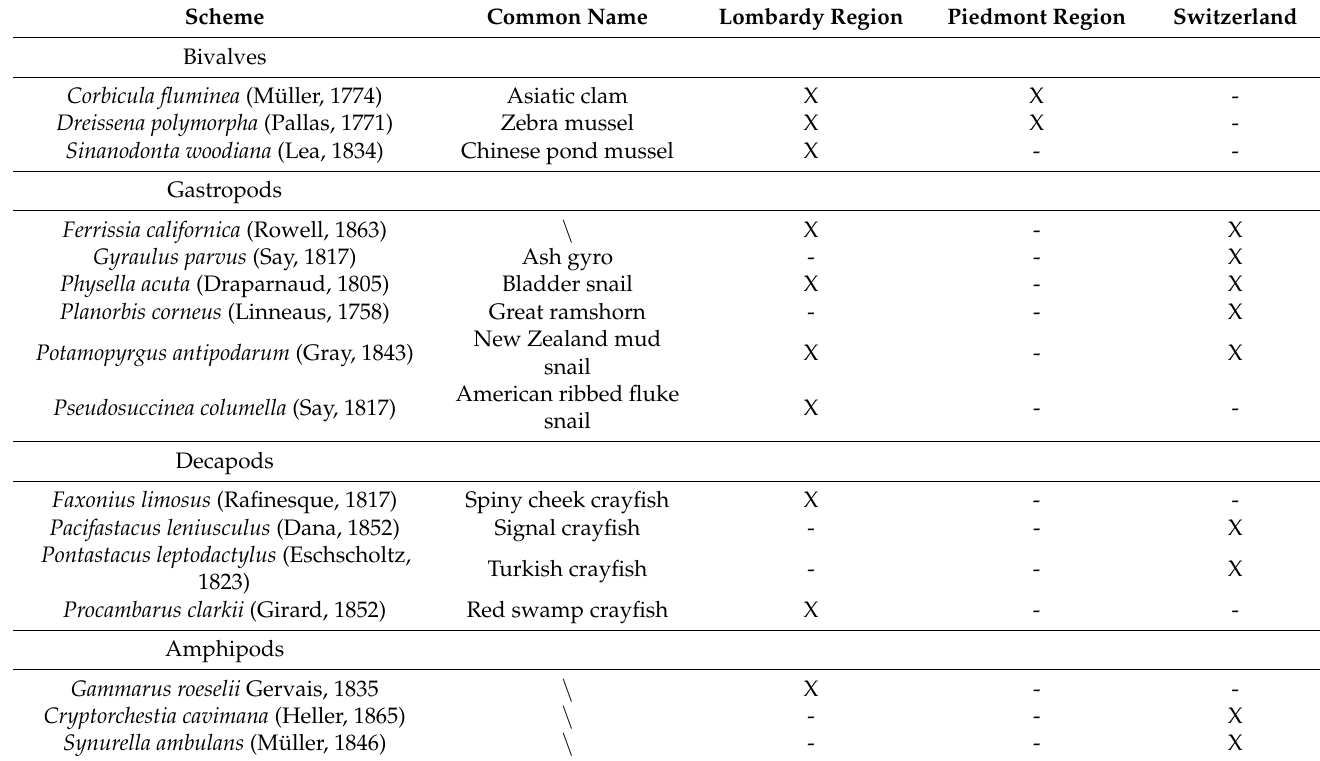
the Lombard Environmental Agency (ARPA Lombardia) indicates the presence of 10 IAS, while in Switzerland, the governmental monitoring program indicates the presence of 9 IAS in the tributaries of the lake (Table 1). Table 1. List of freshwater alien species examined with AS-ISK in the catchment area of Lake Maggiore. The X indicates the presence of the species in the database.